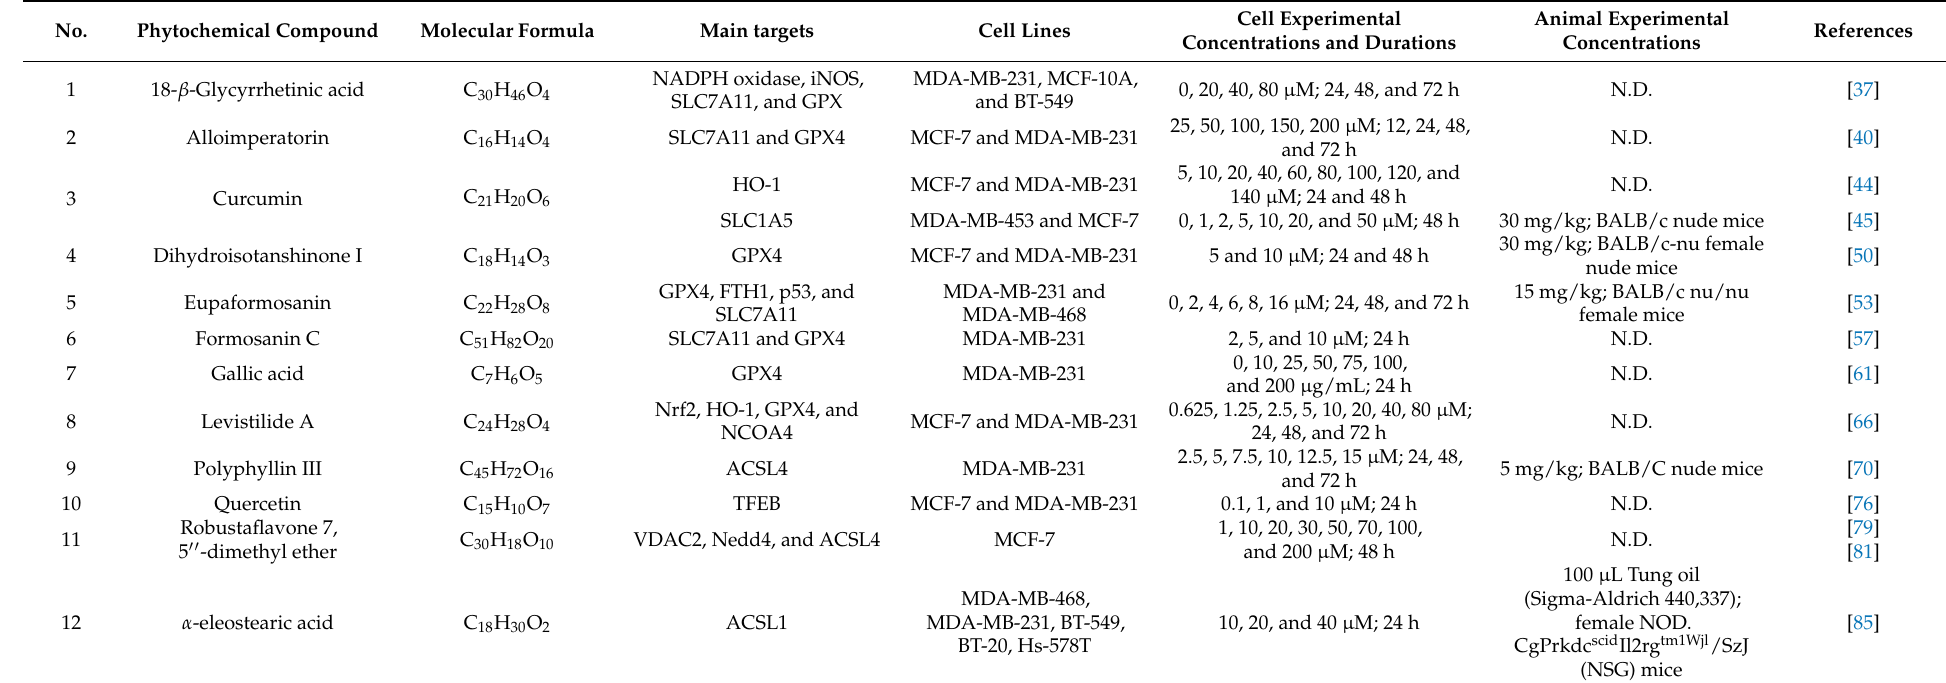
Table 1. Phytochemical compounds modulate ferroptosis in treating breast